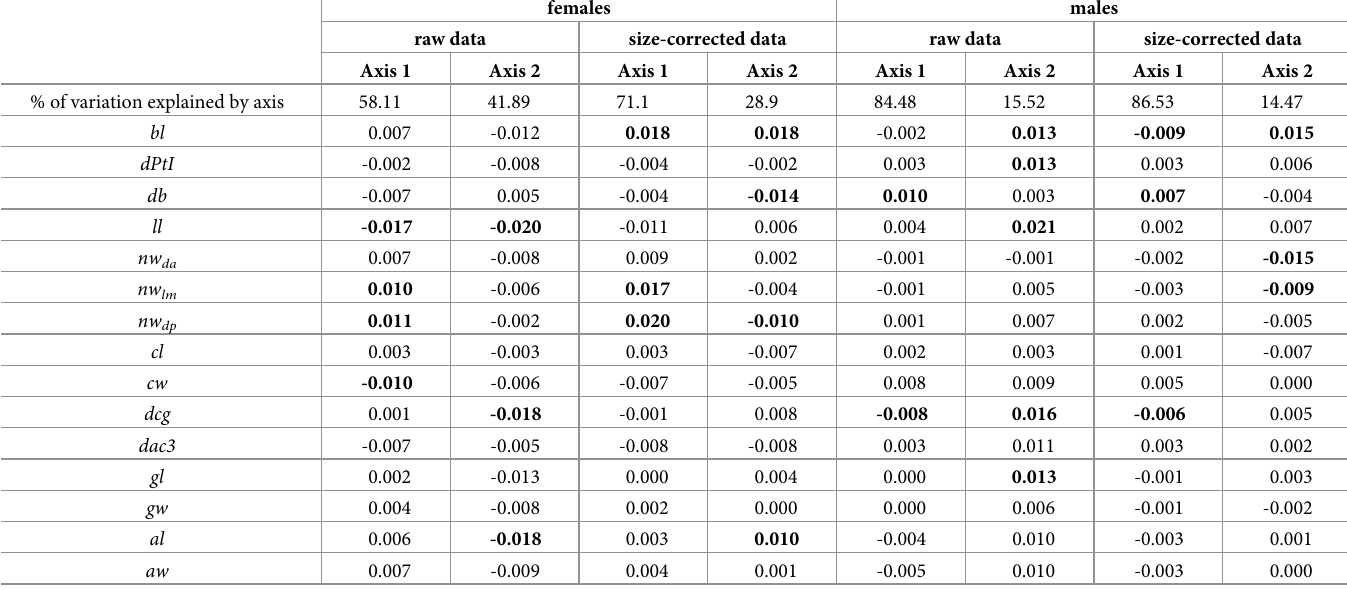
Table 3. Loadings of variables in CVA on raw and size-corrected data of females and males. Loadings with the first three highest values are in bold. females raw